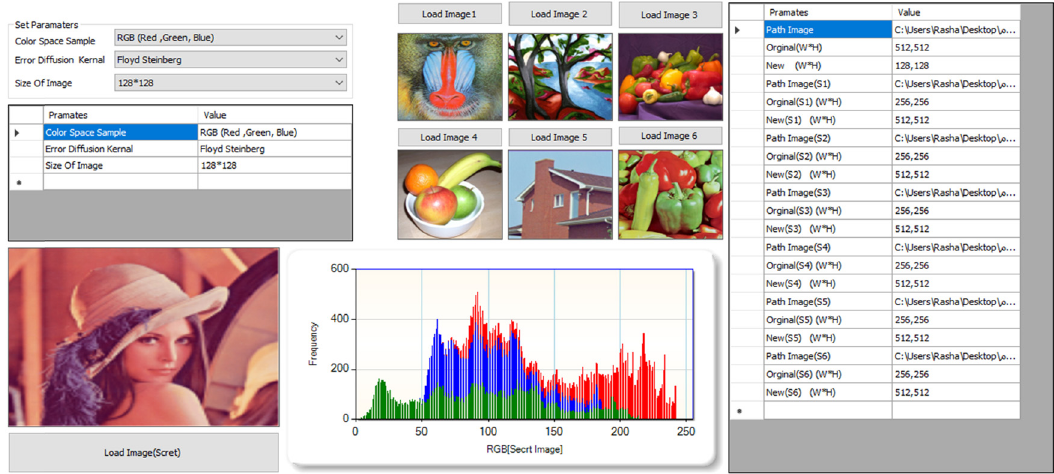
Figure 9: The interface of loaded secret and cover images by the